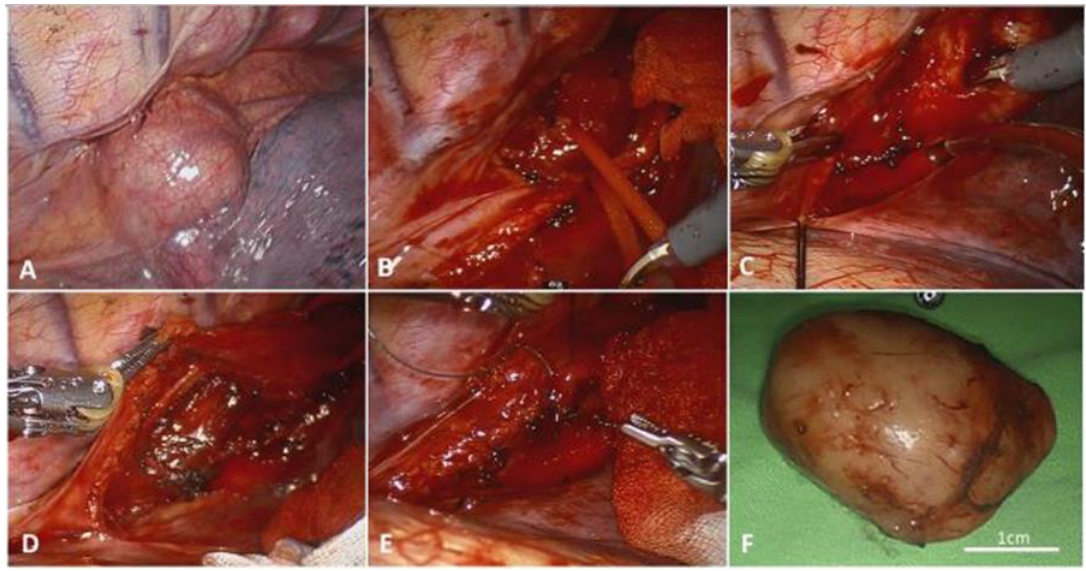
Figure 1. Case 15. ( A ) Esophageal mesenchymal tumor at the lower thorax. ( B ) Retracting the mo- bilized esophagus. ( C ) Longitudinal myotomy and tumor excision at the submucosal layer. ( D ) No mucosal perforation was noted. ( E ) Repairing the myotomy with 3-0 V-loc. ( F ) A 4 cm well circum- scribed tumor, pathology confirmed GIST, and Glivec was